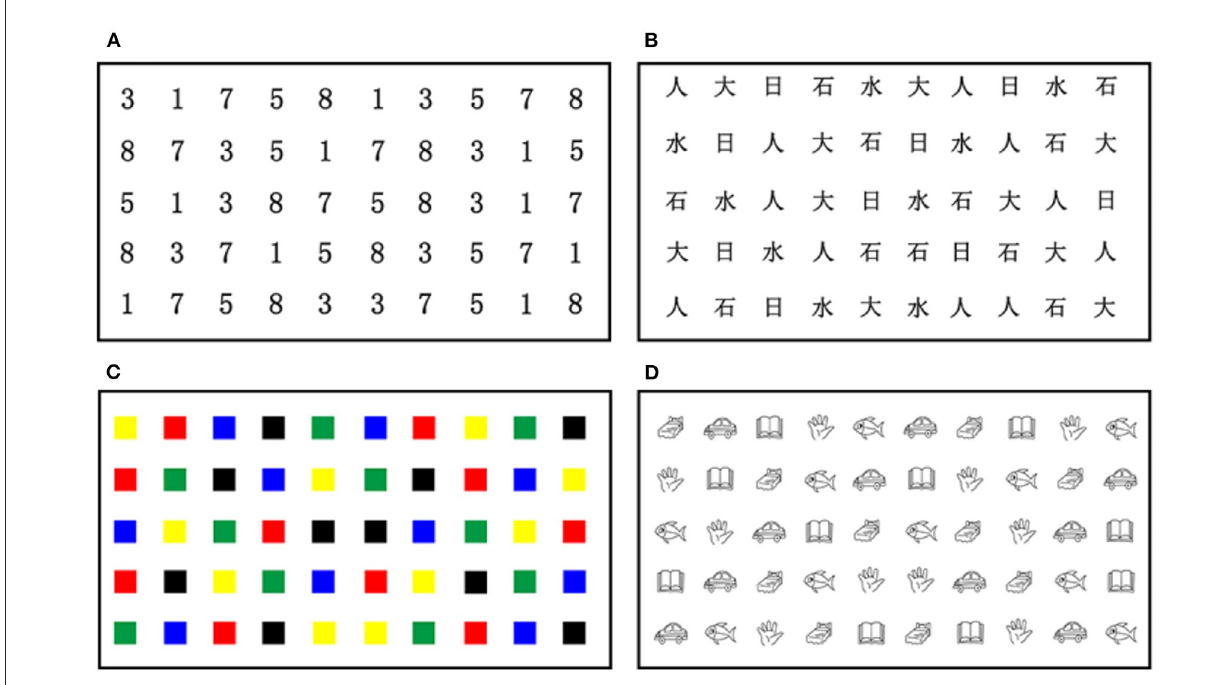
FIGURE1 The Chinese RAN paradigm presented a 5 × 10 matrix of stimuli (e.g., numbers, Chinese characters, colors, or objects) in different tasks: (A) Task N-num (i.e., naming of numbers); (B) Task N-cha (i.e., naming of Chinese characters); (C) Task N-col (i.e., naming of colors); and (D) Task N-obj (i.e., naming of objects). RAN, rapid automatized